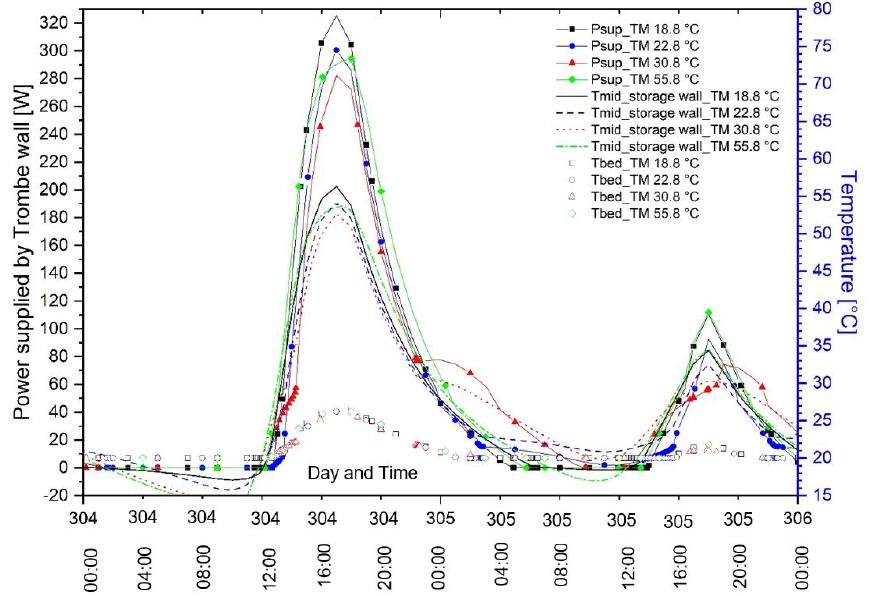
Figure 6. Variations in: the power supplied by the solar Trombe wall, temperature at the center of the phase change material (PCM) storage wall and temperature inside the